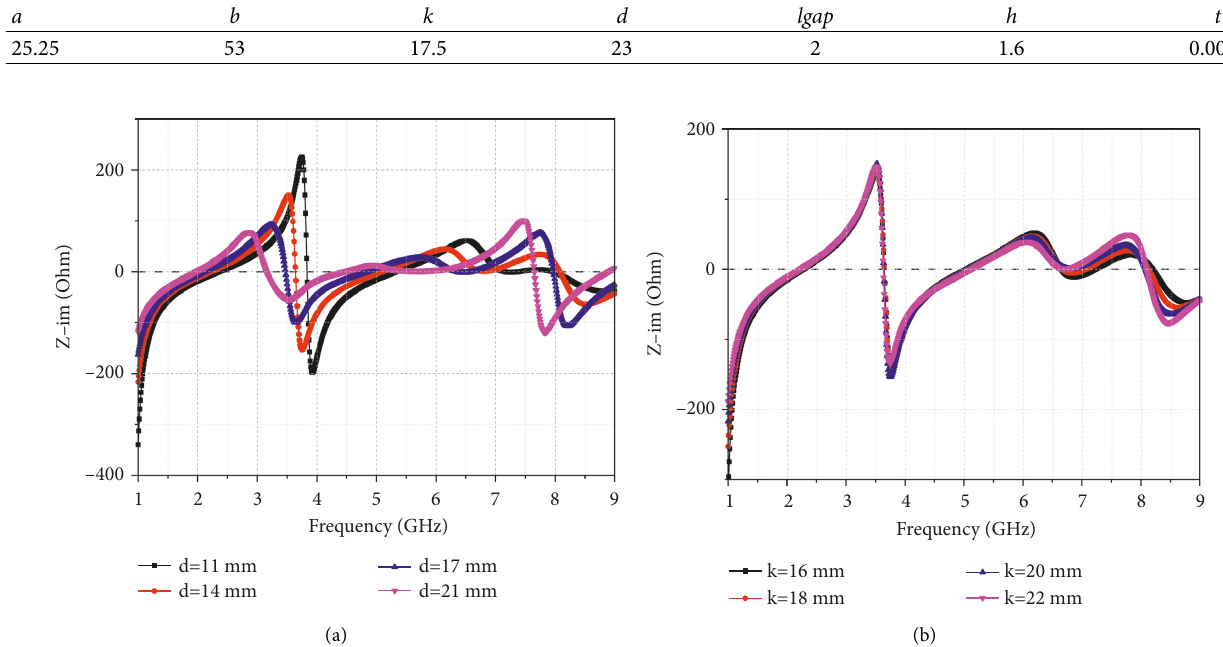
Figure 2: Imaginary parts of the input impedance of antenna 1. (a) Different d when k � 25mm; (b) different k when d � 23mm.